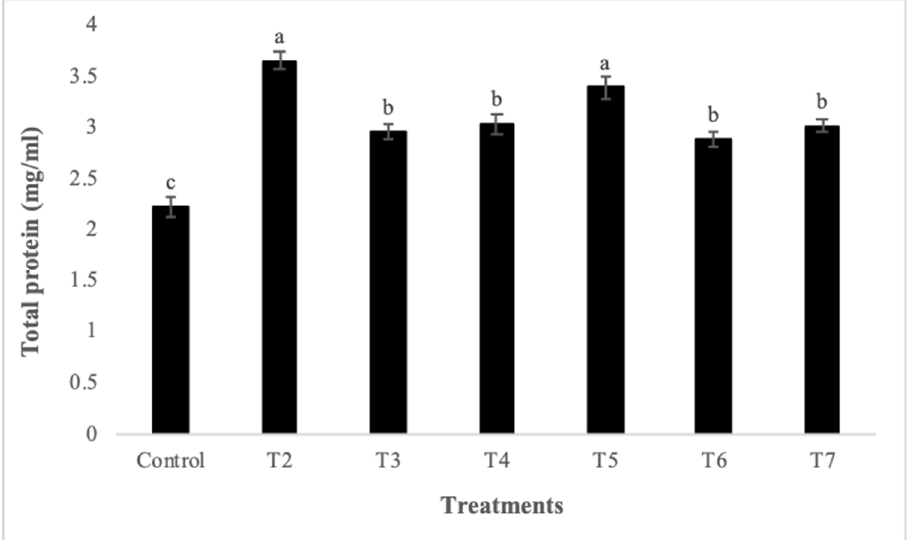
Figure 1. Skin mucus immune parameters of zebrafish fed on diets with different levels of synbiotic Biomin ® IMBO and/or Persian shallot for 60 days. T1, control (without any supplementation); T2, 1% synbiotic; T3, 3% synbiotic; T4, 1% Persian shallot; T5, 3% Persian shallot; T6, 1% Persian shallot and 1% synbiotic; T7, 3% Persian shallot and 3% synbiotic. Data are expressed as the mean ± SE. Different letters (a–e) in the same row indicate significant differences among the treatments ( p < 0.05).